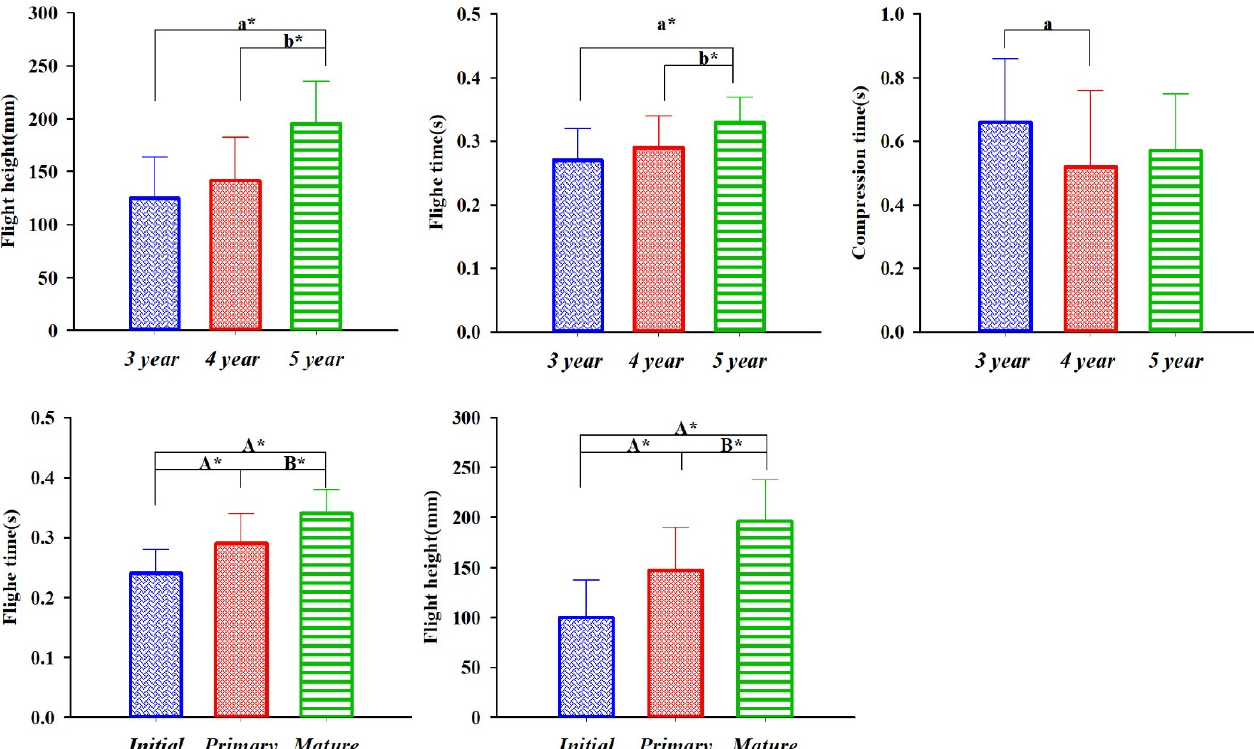
Figure 4. Results of main effect of spatiotemporal parameters. Notes: “a” means a significant difference compared with the 3-year-old group, “a*” means a very significant difference. “b*” means a very significant difference. A* means a very significant difference compared with the initial stage; B* means a very significant difference compared with the primary stage. Table 4. Results of main and interaction effect of joint angle and angular velocity